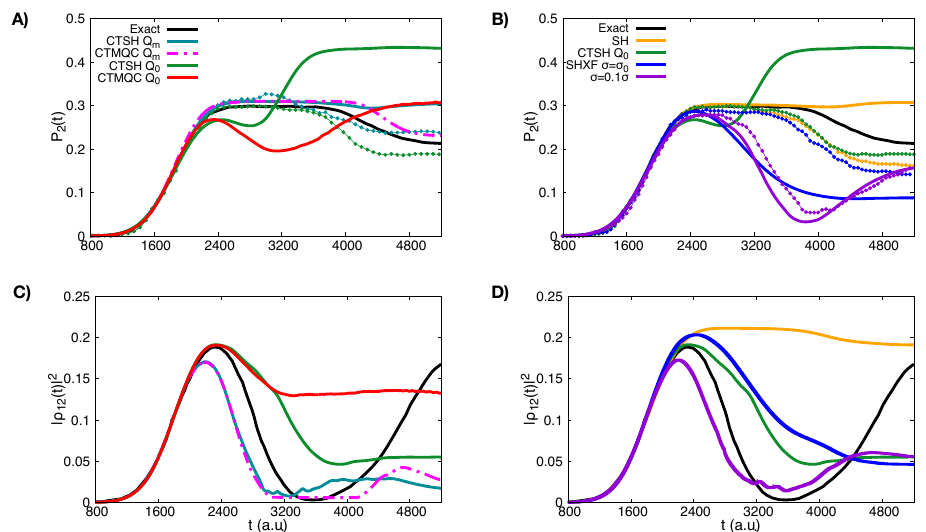
Figure 5. Upper panels: electronic populations ( A , B ) of the excited state (solid) and fraction of trajectories on the excited state (dotted) are plotted for ECR model with k 0 = 10 a.u. Lower panels: electronic coherences ( C , D